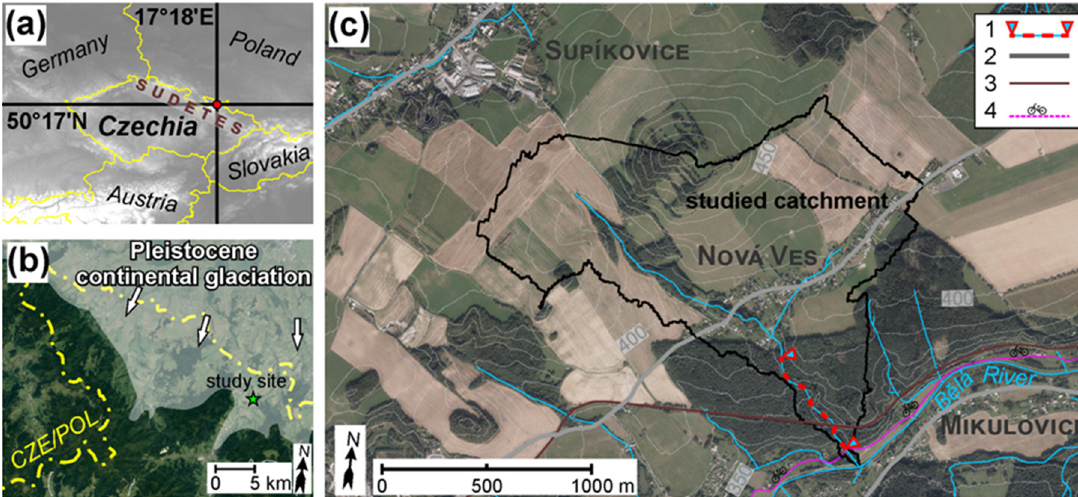
Figure 1. Location of the study site: position within Central Europe ( a ), within the Eastern Sudetes ( b ), and ( c ) orthophoto image of the studied catchment (1—study channel reach, 2—main road, 3—railway and 4—cycle path).